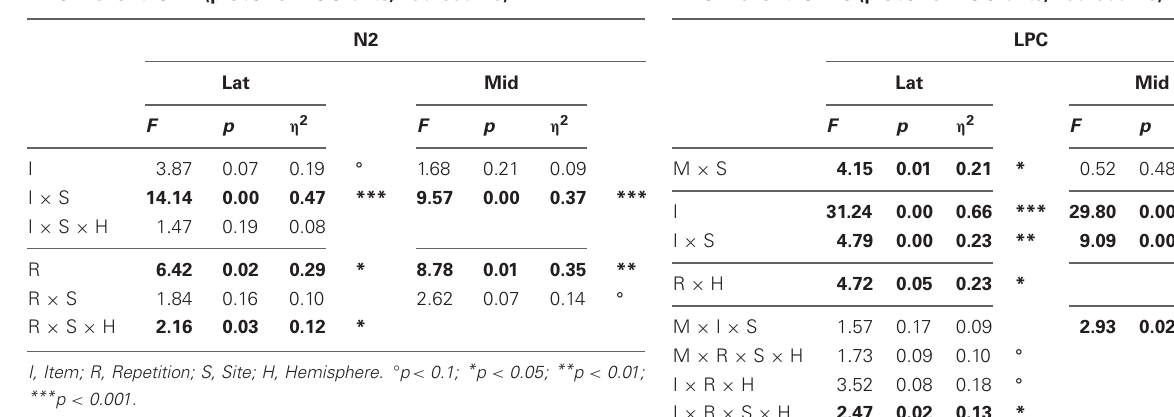
Table 1 | Results of the omnibus lateral (Lat) and midline (Mid) ANOVAs for the N2 (probe vs. irrelevants, 250–350ms).